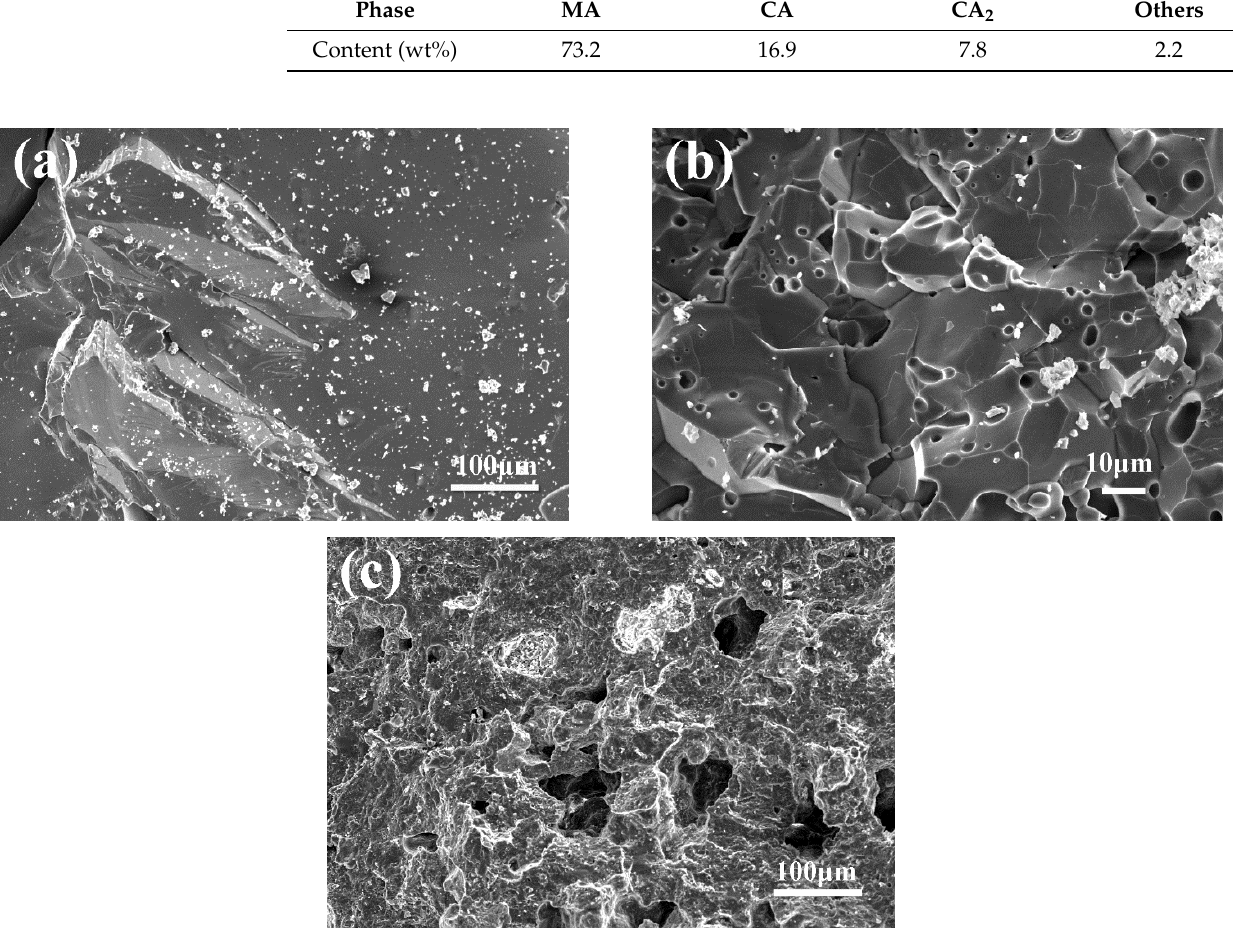
Figure 1. Microstructure of three aggregates: ( a ) white fuse alumina, ( b ) tabular alumina and ( c ) CMA aggregates. After casting, all castables were cured under the conditions of 20 °C and 70–75% rel- ative humidity for 48 h, then dried at 110 °C for 24 h. All samples were calcined at 1100 °C and 1550 °C for 3 h, respectively. The apparent porosity and bulk density of samples were measured by the Archimedes technique using the GB/T 2997-2000 standard [17]. The cold modulus of rapture (CMOR) was measured with three-point bending tests following GB/T 3001-2007 [18]. The phase composition of castables was characterized by X-ray dif- fraction (XRD, X’pert Pro MPD, Philips, Almelo, The Netherlands). Microstructure of